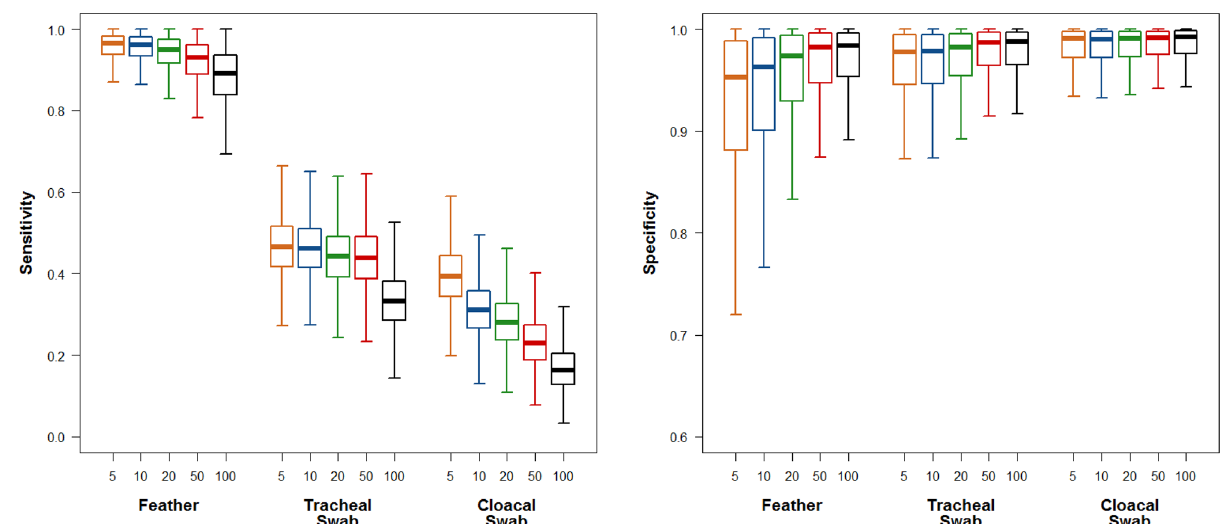
Figure 3. Estimated sensitivity (left panel) and specificity (right panel) of the three different sample types (feather sample, tracheal swab and oropharyngeal swab) for 5 different thresholds of positivity (5, 10, 20, 50 and 100 copies of